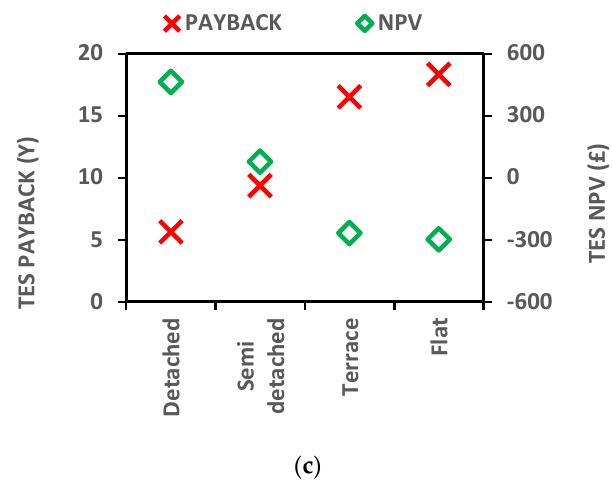
Figure 10. Payback and Net Present Value (NPV) associated with TES investment for ( a ) non-incentivised design; ( b ) incentivised design (FIT); and ( c ) incentivised design (CO 2 levy exemption).